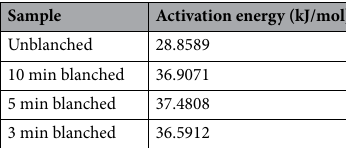
Table 2. Activation energy of MBF.